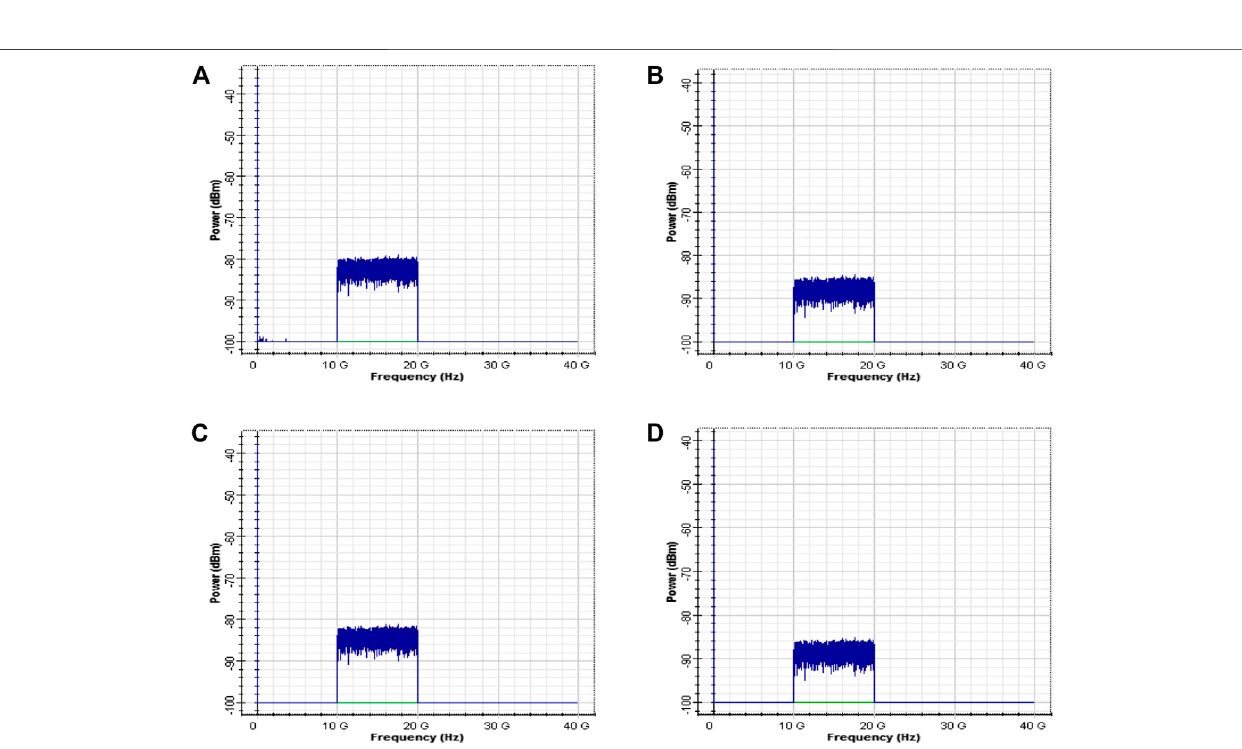
Frontiers in Physics |